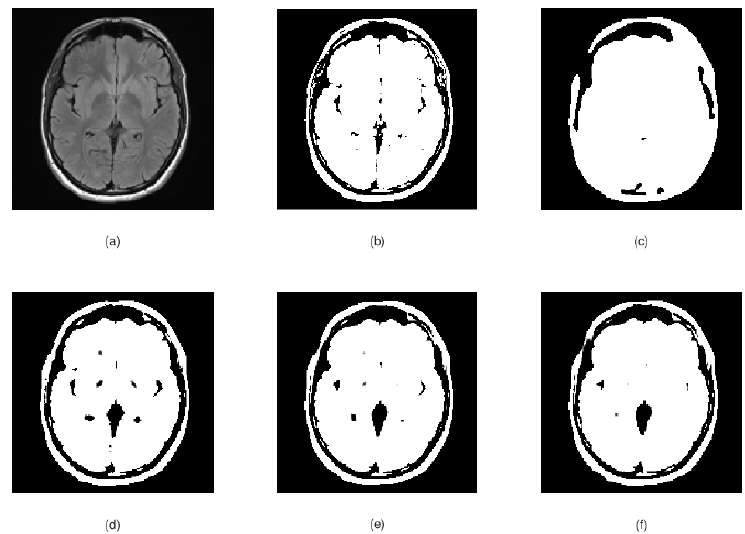
Figure 1. ( a ) Original input image to be segmented, ( b ) K-means segmentation results, ( c ) Chan–Vese segmentation results; and ( d–f ) our model segmentation results after 1–3 iterations, respectively.